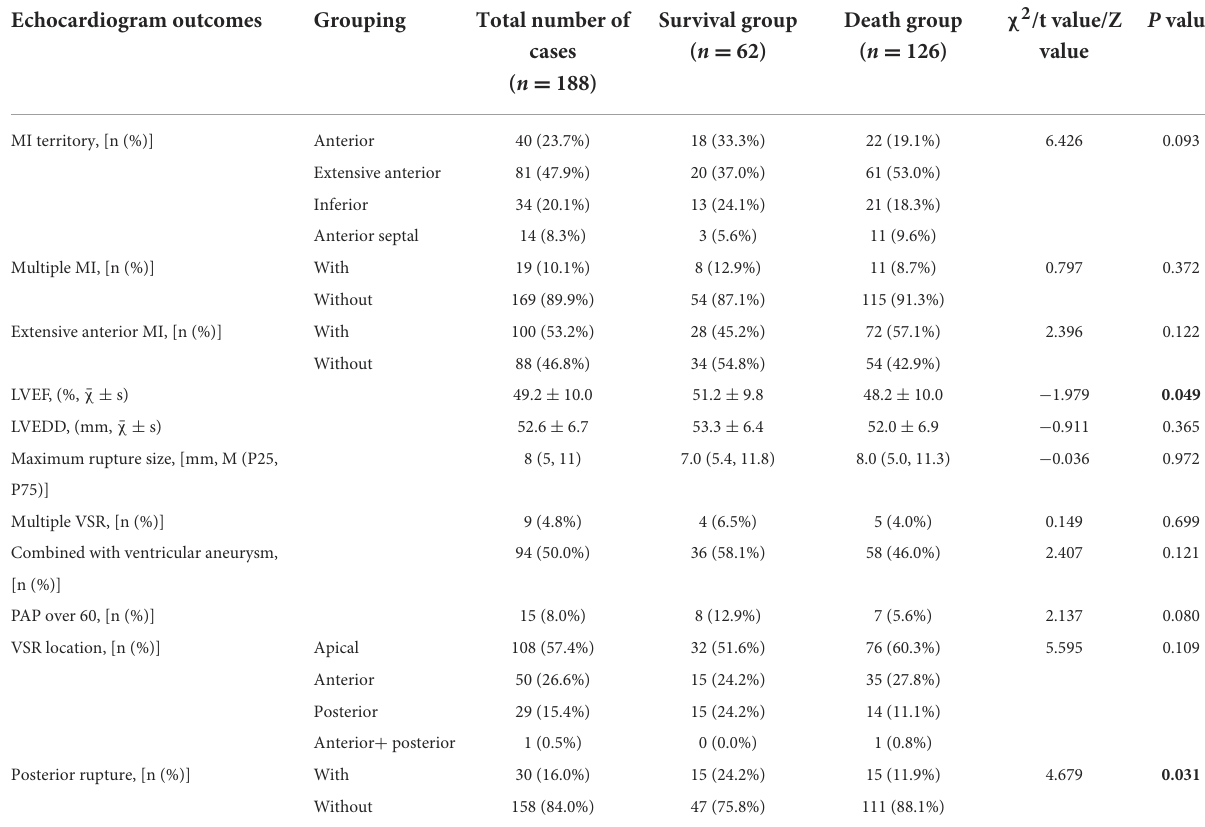
TABLE 3 Echocardiogram outcomes of VSR patients stratified by different prognosis. Echocardiogram